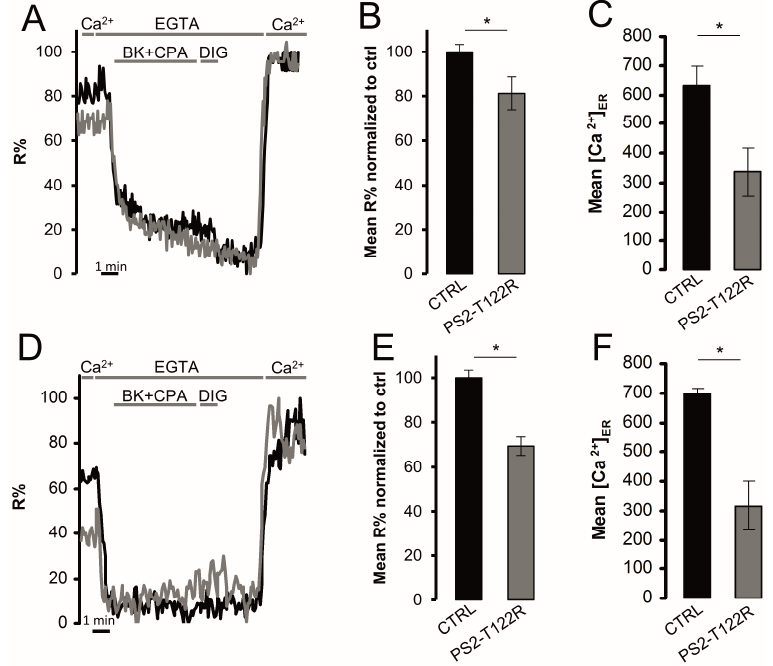
Figure 5. ER Ca 2+ content variations upon PS2-T122R cell expression. The protocol described in Figure 1D has been applied to BHK cells co-expressing either D1ER ( A – C ) or D4ER ( D – F ) and PS2-T122R (grey traces) or the void vector (black traces), as controls; ( A , D ) representative traces are shown and represent R% variations upon different additions; ( B , E ) histograms show basal mean R% normalized to those obtained in void vector-transfected controls, in BHK cells expressing the D1ER ( B ) or D4ER ( E ) probe (mean ± s.e.m., N ≥ 16 cells for each condition); and ( C , F ) the conversion of calculated R% values in [Ca 2+ ], measured using the D1ER ( C ) or D4ER ( F ) probe (mean ± s.e.m.; N ≥ 33). * = p < 0.05, unpaired Student’s t test.